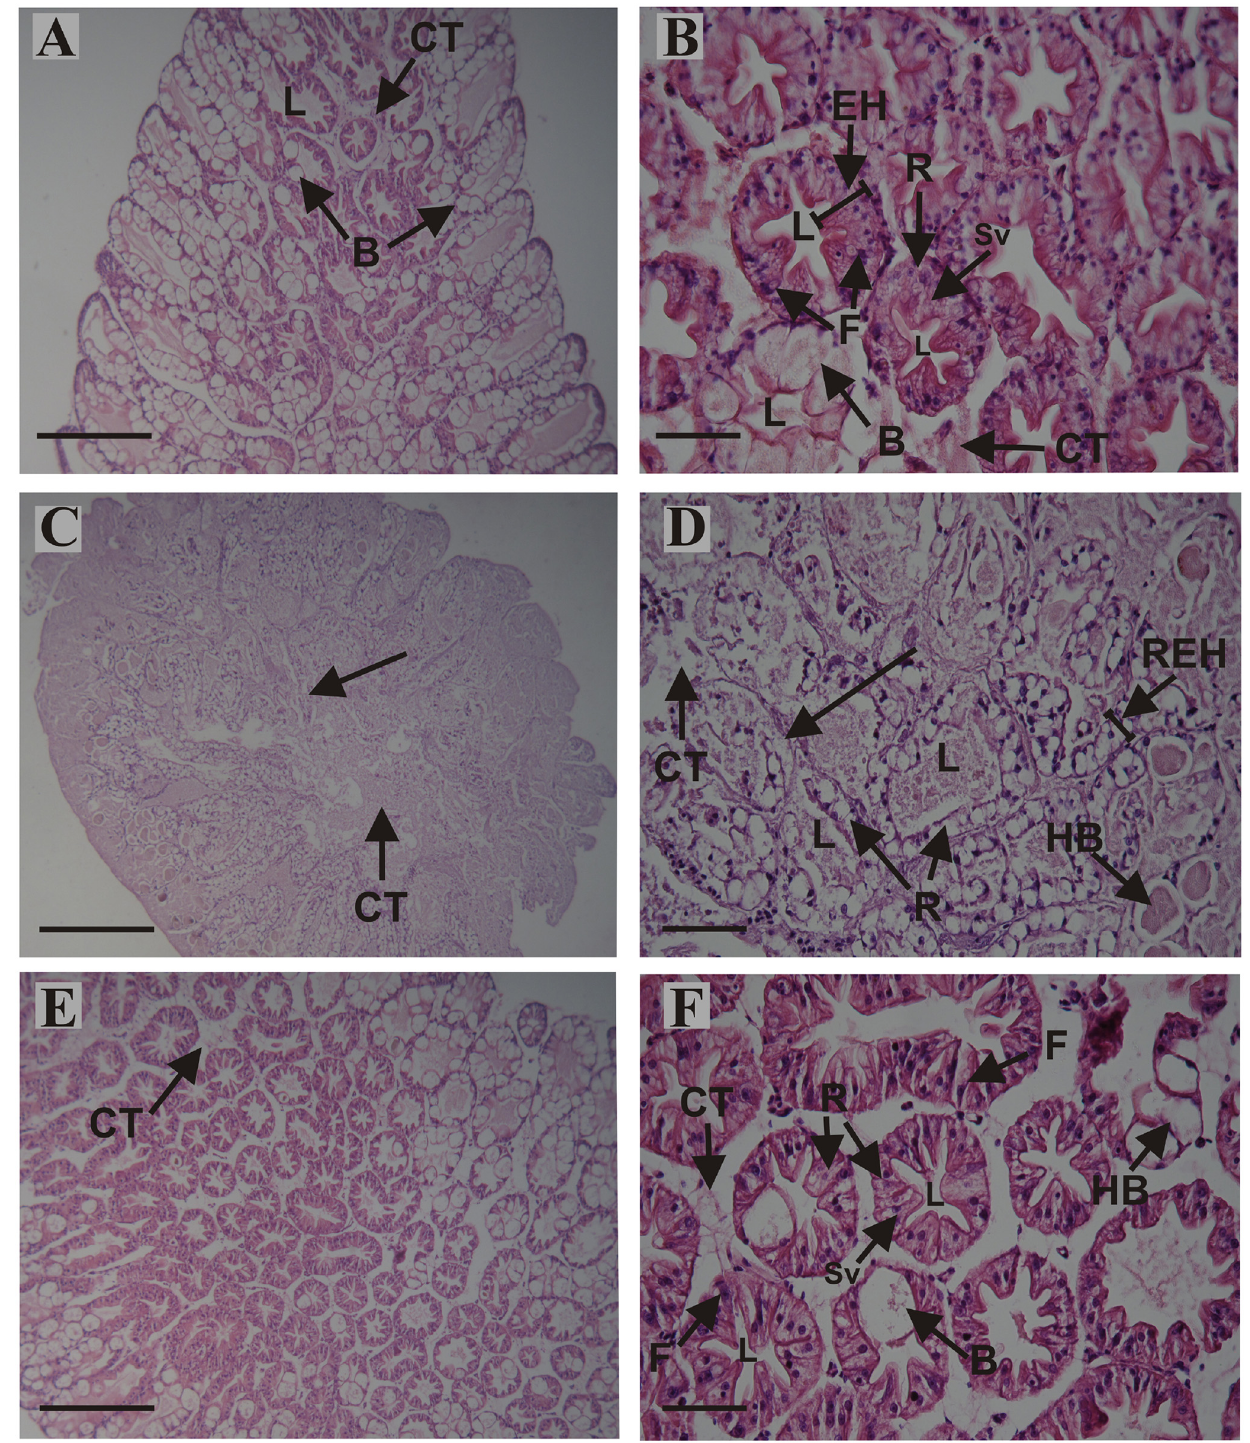
Fig 6. Histological sections of the midgut gland from juveniles of Cherax quadricarinatus continuously fed (A, B), abnormalities after long-term starvation (C, D), and abnormalities after long-term starvation and posterior feeding (E, F). (A, C, E): longitudinal section of the apical portion of the tubules; (B, D, F): cross sections of the tubules. (A) and (B): midgut gland structure, connective tissue (CT), epithelial height (EH), F cell, B cell and R cell with small vacuoles (Sv) of fed animals was preserved. (C): structural loss (arrow) and disorganization of connective tissue. (D): undifferentiated epithelium (arrow), partial disorganization of connective tissue (CT), reduction in epithelial height (REH), hypertrophy of B cells (HB), R cells without small vacuoles,